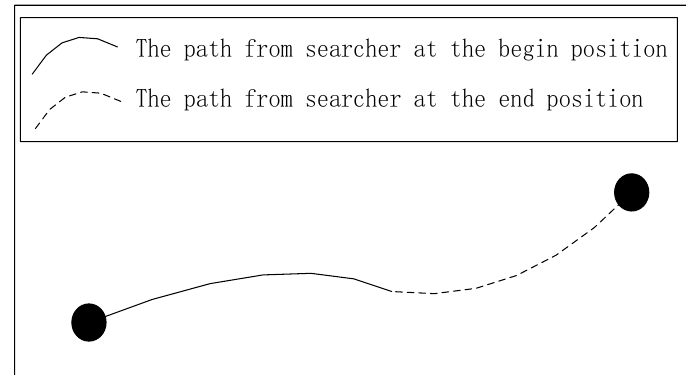
Figure 7. Two searchers meet at a point.